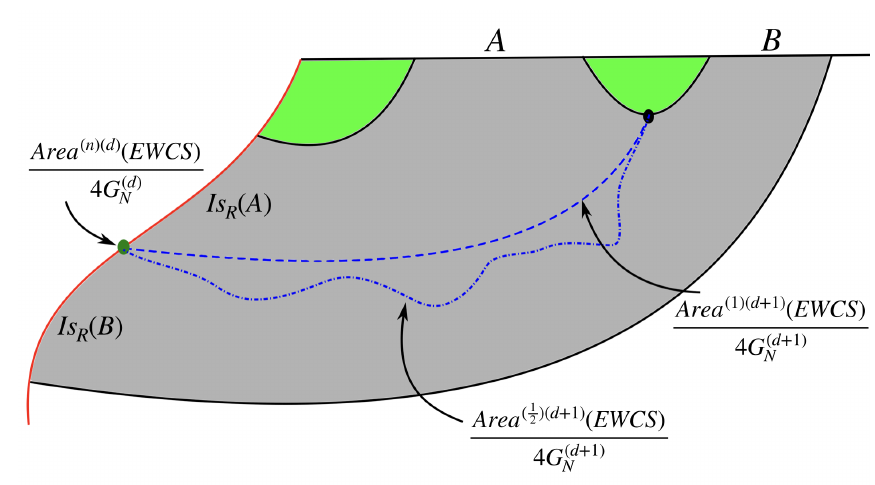
Figure 27: Schematic for double holography picture of our proposal-II. Note that the superscript in the first bracket in the area terms denotes the Renyi index, and the one in the second bracket indicates the dimension of the spacetime in which the surface is